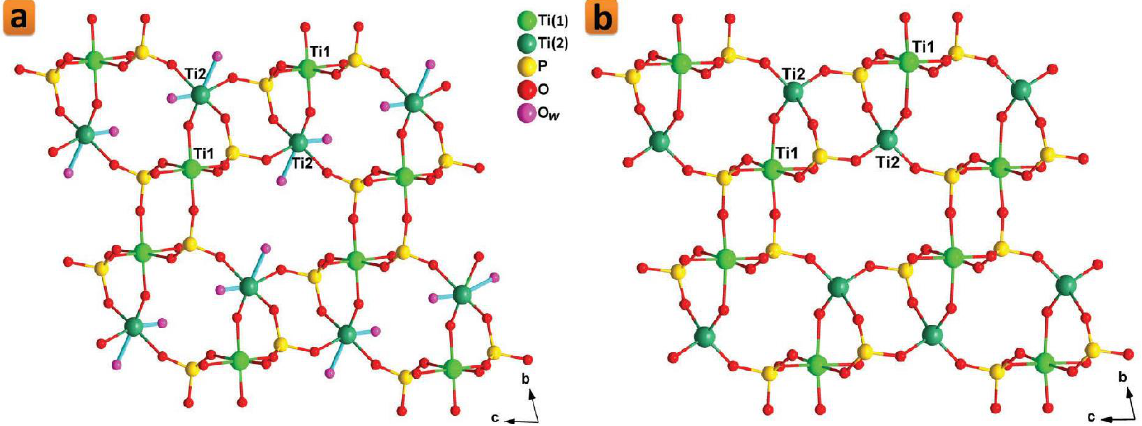
Figure 3. Crystalline structure of the dihydrate ( a ) and anhydrous ( b ) phases of ρ -TiP. Reprinted with permission from reference [86], License number: